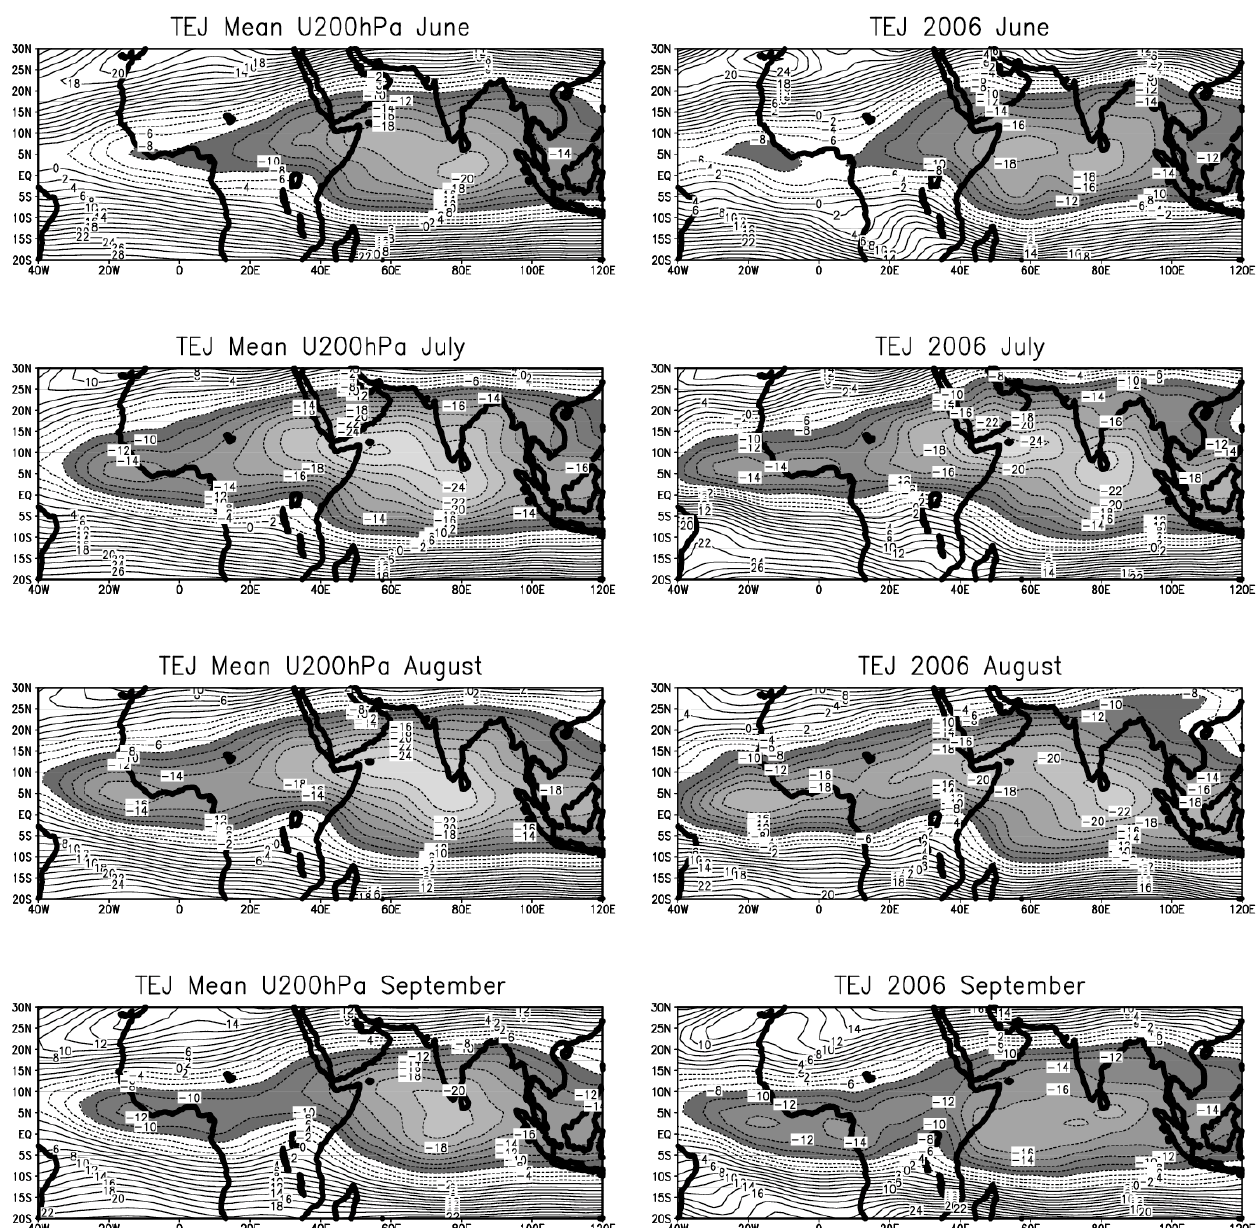
Fig. 5. Left: 1979–1999 averaged zonal wind fields at 200hPa, in June, July, August, September from NCEP. Right: Same wind fields but for 2006. Shaded areas for easterly wind component higher than 8ms − 1